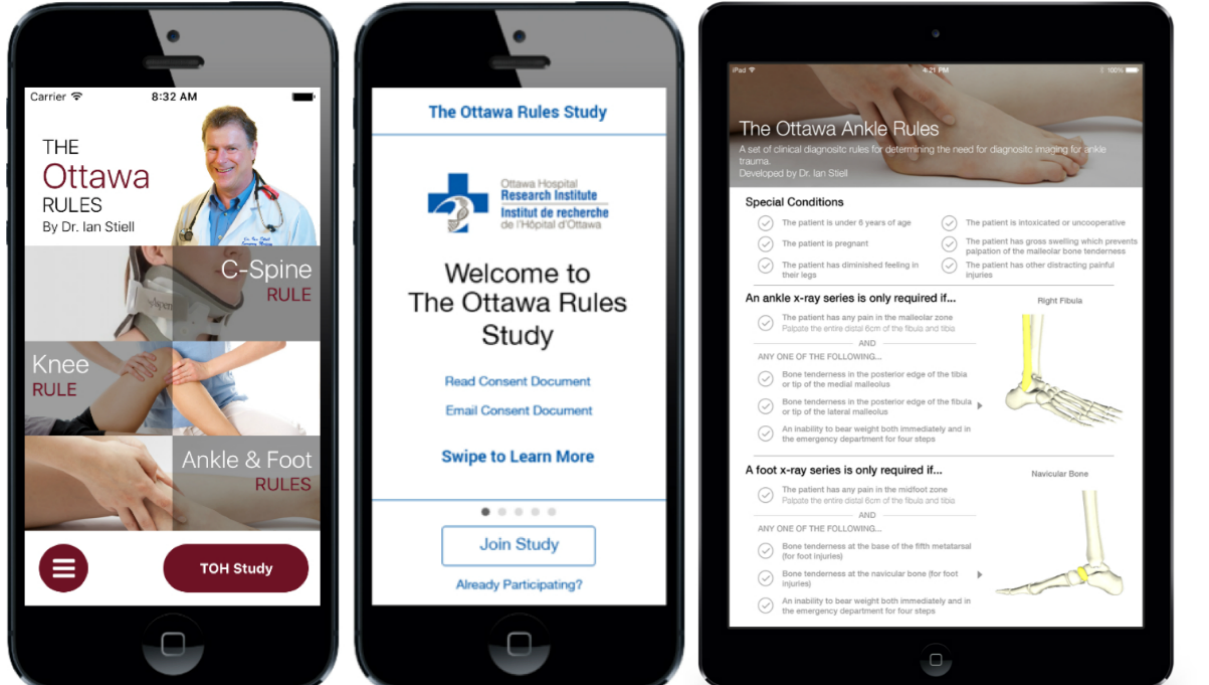
Figure 1. The Ottawa Rules interfaces on Android and